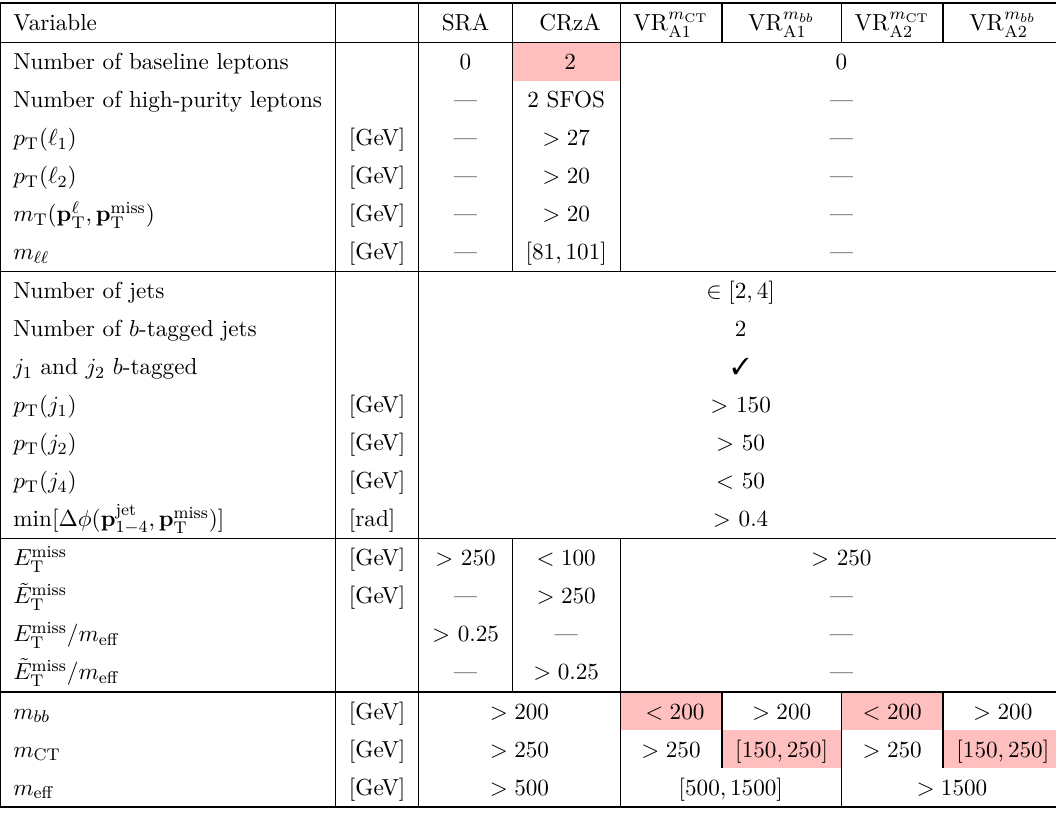
Table 2 . SRA signal, control and validation region definitions. Pink cells for the control and validation regions’ columns indicate which selections ensure that the regions are orthogonal to the